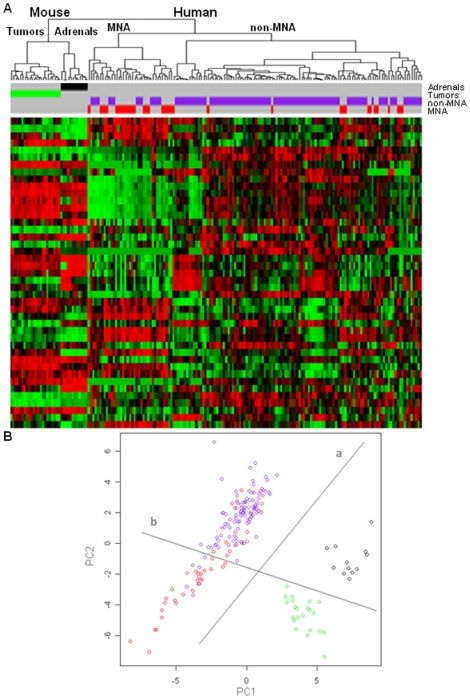
Analysis of human and mouse samples based on miRNAs (n = 43) deregulated in human MNA.(A) Hierarchical clustering (n = 43). Cluster “Mouse” contains all the mouse samples, split in two branches “Tumors” and controls “Adrenals”. Cluster “Human” includes all the human samples split in two branches which shows an enrichment (p<0.05) for MNA tumors (59.5%, in cluster “MNA”) and an under-representation of MNA samples (12.9%, in cluster “non-MNA”), respectively. (B) Principal component analysis. Line “a” splits the samples based on the species: human (left) and mouse (right). Line “b” shows a distribution of the samples according to MYCN expression: a clear split in the mouse and an enrichment (p<0.001) for human MNA samples (under). Mouse tumors (green), mouse adrenals (black), human MNA (red) and human non-MNA (purple).